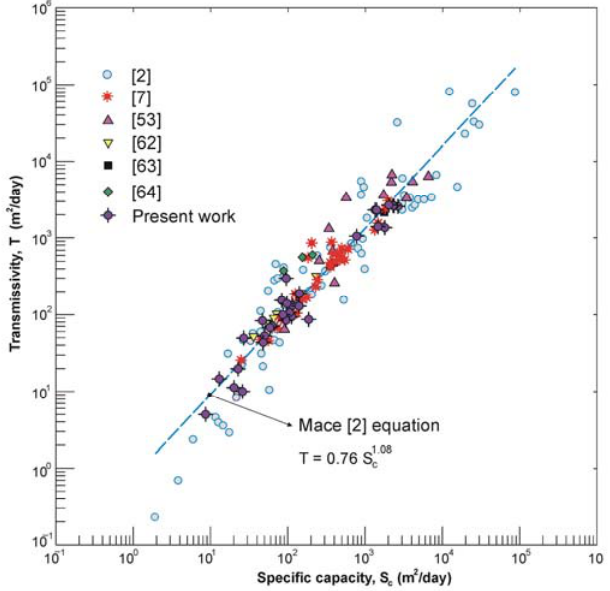
Figure 6. Specific capacity and transmissivity data of fractured and karstified aquifers worldwide based on [2,7,53,62–64]. When not available in publications, data have been picked from Mace [3] by using Engauge Digitizer free software..